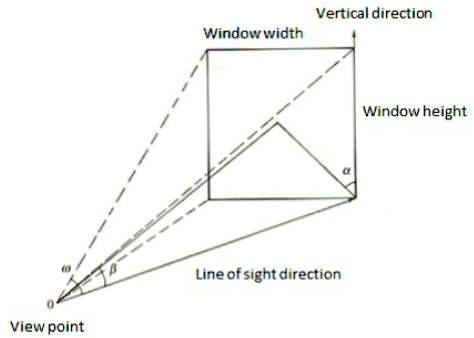
Figure 12. The scheme that displays the angles α , β and solid angle ω .